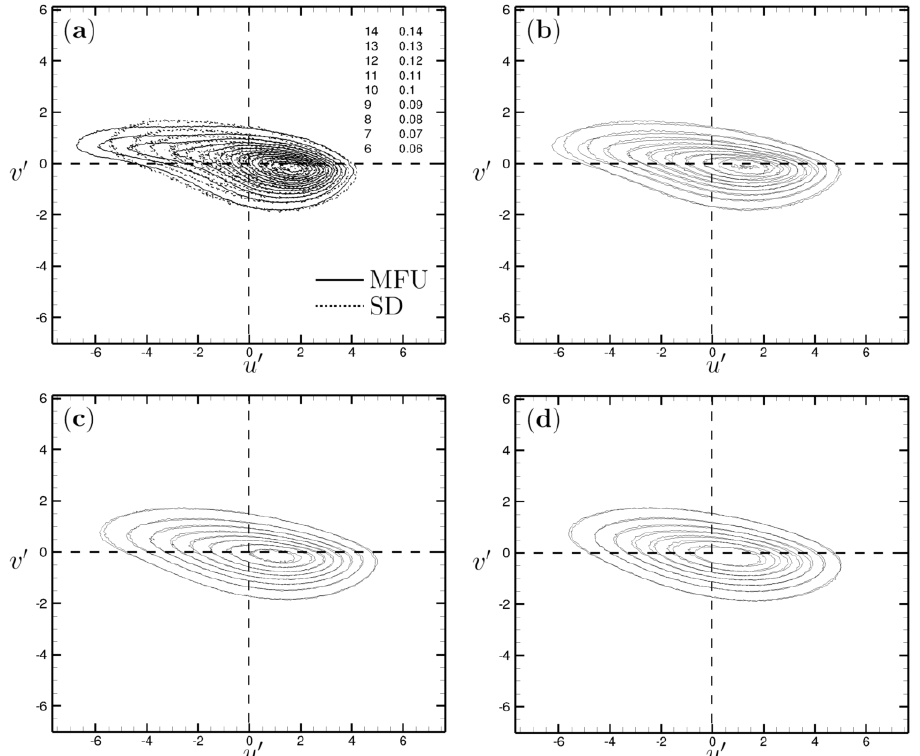
Figure 6. Contours of joint probability density functions for streamwise and wall-normal velocity fluctuations in a wall-normal plane at y + ≈ 30 for MFUs (solid lines) and SDs (dashed lines) in an extended domain. Values were normalized by their respective friction velocities. Re τ = ( a ) 200, ( b ) 500, ( c ) 700, and ( d )